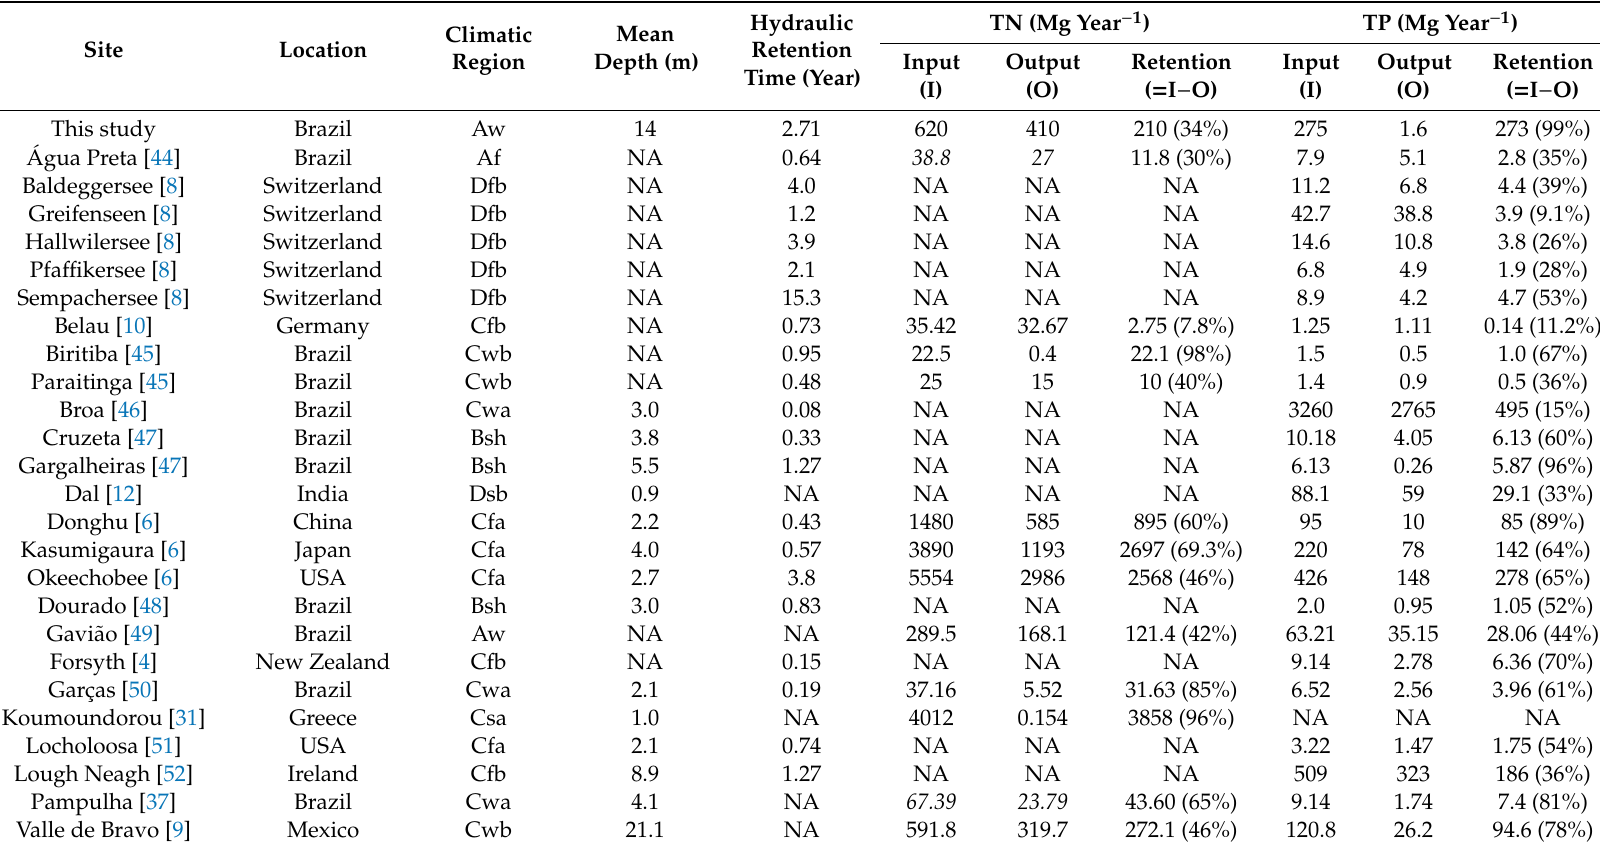
Table 4. General features, input, output, and nutrients (total nitrogen and total phosphorus) retention in lakes and reservoirs in this study and